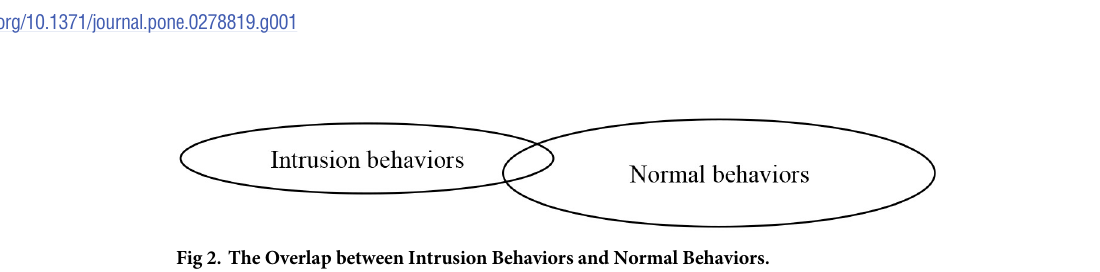
Fig 1. Evaluation results of ResNet on KDDTrain+ dataset. The subfigure (a) denotes the CrossEntropy training error of ResNet among epochs. The subfigure (b) denotes the CrossEntropy testing error of ResNet among epochs.